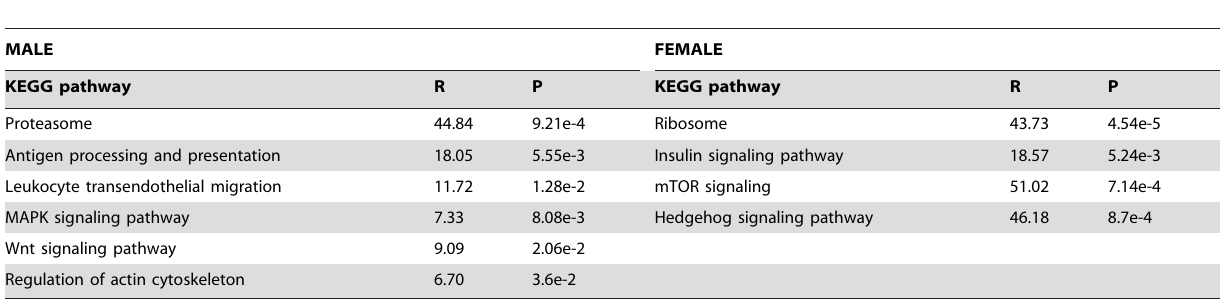
Table 2. Webgestalt KEGG pathway analysis of gonadal transcriptional response to intermittent fasting compared to 20% caloric